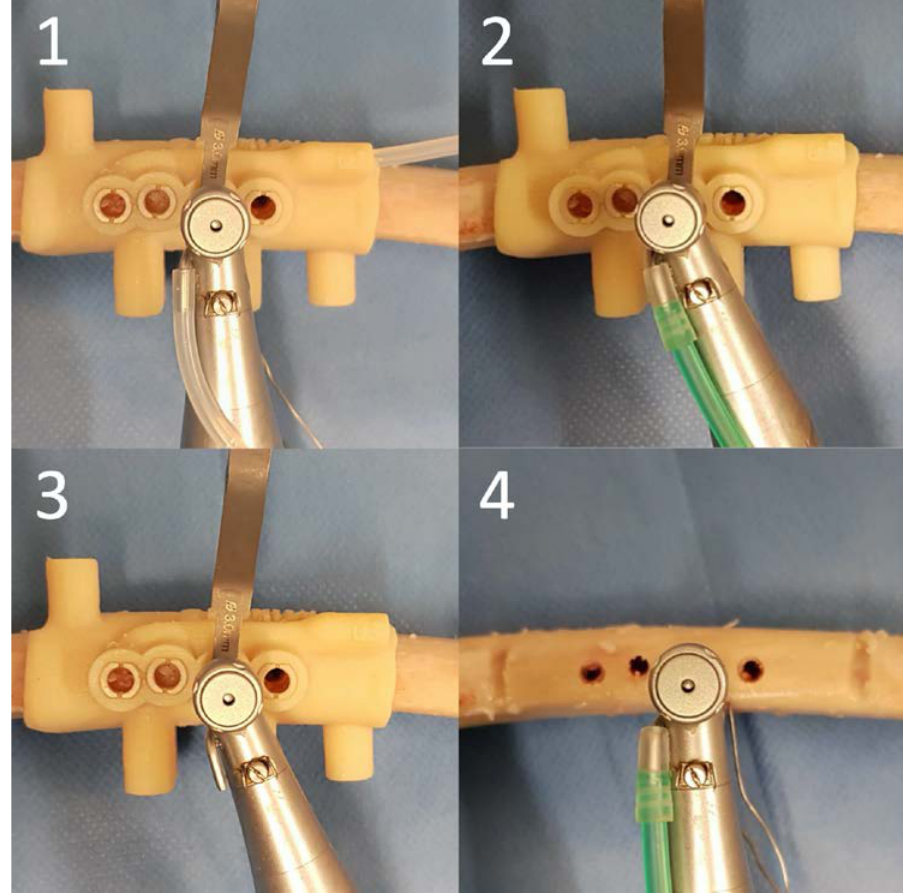
Figure 3. Comparison of the 4 experimental conditions: ( 1 ) guided osteotomy using the surgical guide with external irrigation and an additional internal irrigation with the use of additional built-in tubes (Group 1); ( 2 ) guided osteotomy using the surgical guide with an external irrigation only (Group 2); ( 3 ) guided osteotomy using the surgical guide without irrigation (Group 3); ( 4 ) osteotomy finalized without the use of a surgical guide, with external irrigation (Group 4).